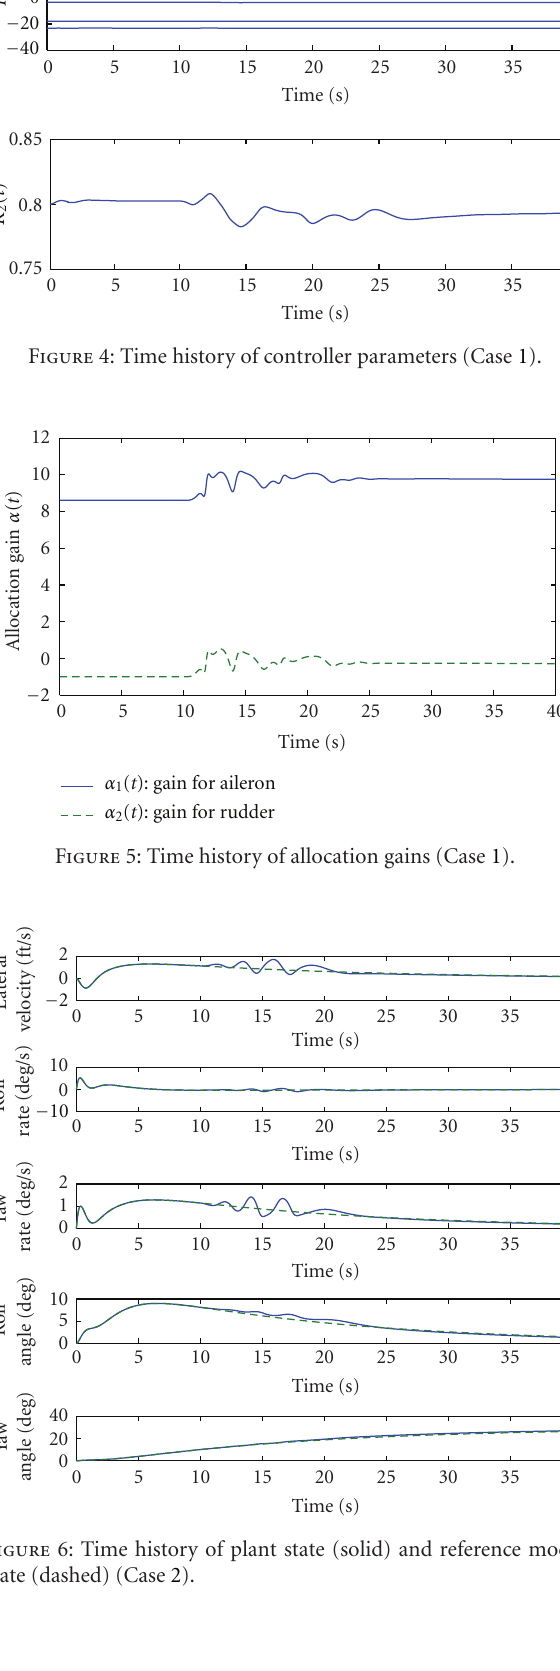
Figure 6: Time history of plant state (solid) and reference model state (dashed) (Case 2).